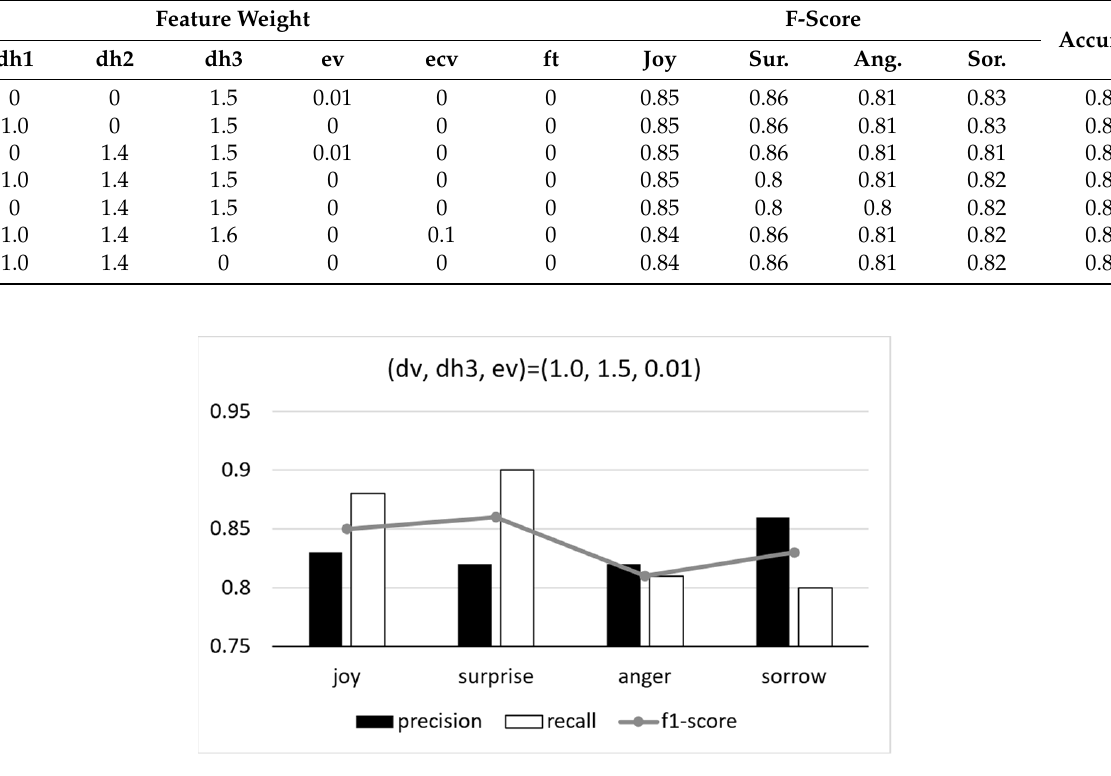
Figure 12. Evaluation results; (ev) = (1.0). 5. Discussion The experimental results of the proposed method show that the highest accuracy was obtained when three types of features were concatenated: features extracted from the mid- dle layer pretrained with DistilBERT (dh3), distributed representation of DistilBERT, and features extracted from the model pretrained by CNN based on the image features of emoticons. In short sentences such as tweets, we expect that the emotions expressed using only emoticons would be important, but the emotion estimation model trained with the character-level CNNs showed low accuracy for estimating the emotion “anger.” Focusing only on the number of examples, the number of cases labeled “surprise” was the lowest, and the next lowest was the number of cases labeled “anger”, suggesting that SMOTE, which is an oversampling method, was able to control the effects of sample size bias to some extent. Although there were few examples in which the emoticons had